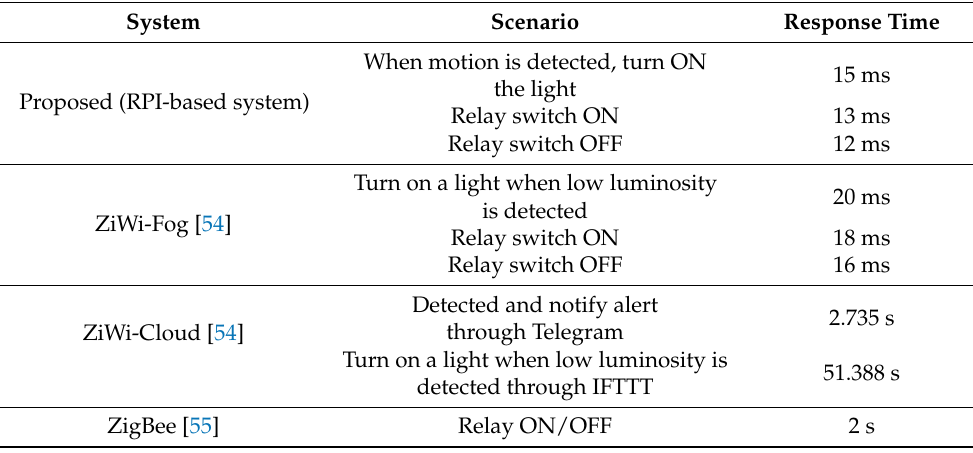
15 ms 20 ms 2.735 s 51.388 s